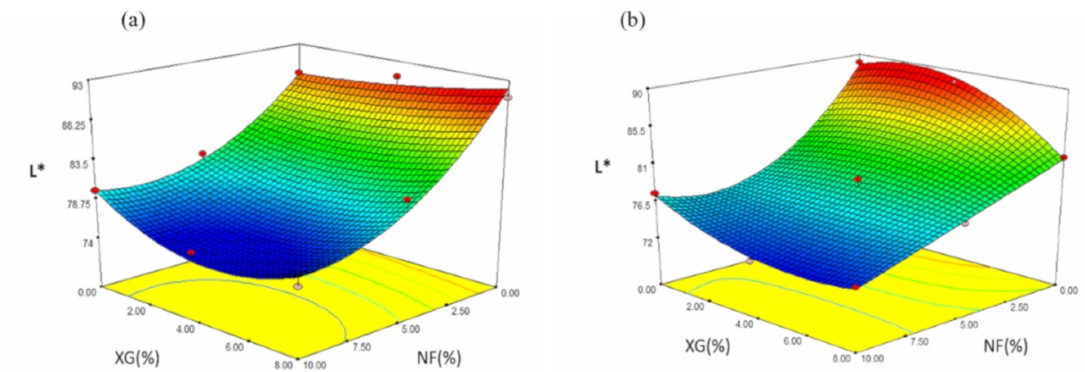
Figure 8. Effect of the interaction of fiber and rubber in the parameter L* in snacks made with: ( a ) native starch and ( b ) starch modified by